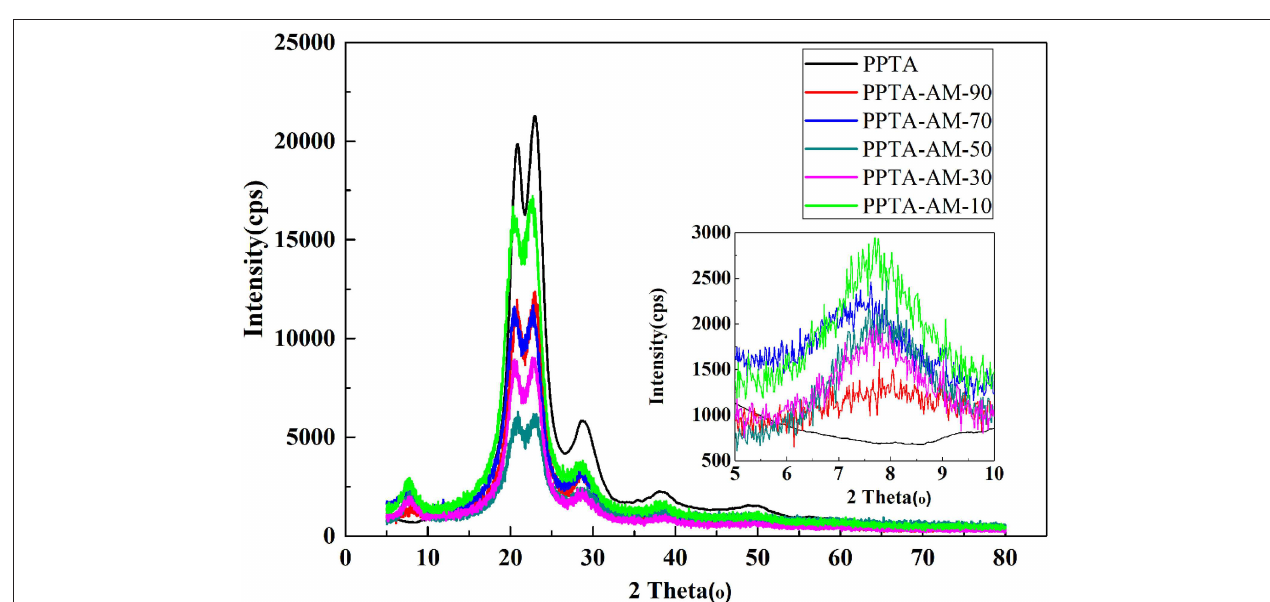
FIGURE 3 | XPS spectra of PPTA and PPTA-AM samples.